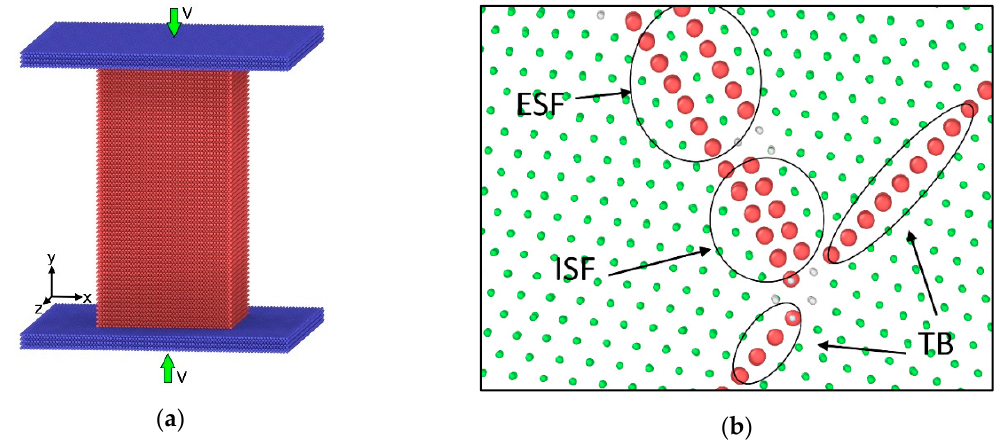
Figure 2. ( a ) Schematic showing the modeled crystallite with h / d = 2; ( b ) crystallite fragment containing intrinsic stacking fault, extrinsic stacking fault and twin boundary. Common Neighbor Analysis (CNA) was used to visualize the defects: hexagonal close-packed (HCP) atoms are shown as red dots and face centered cubic (FCC) atoms are indicated as green dots.